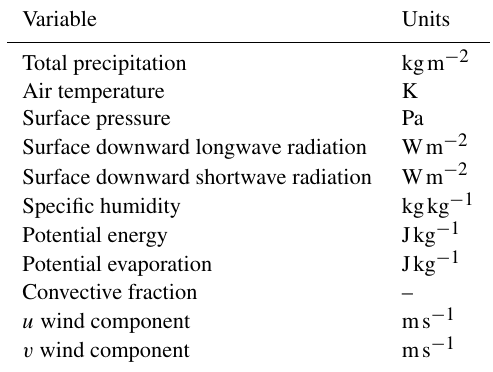
Table 1. NLDAS forcing variables used in this study (Xia et al.,